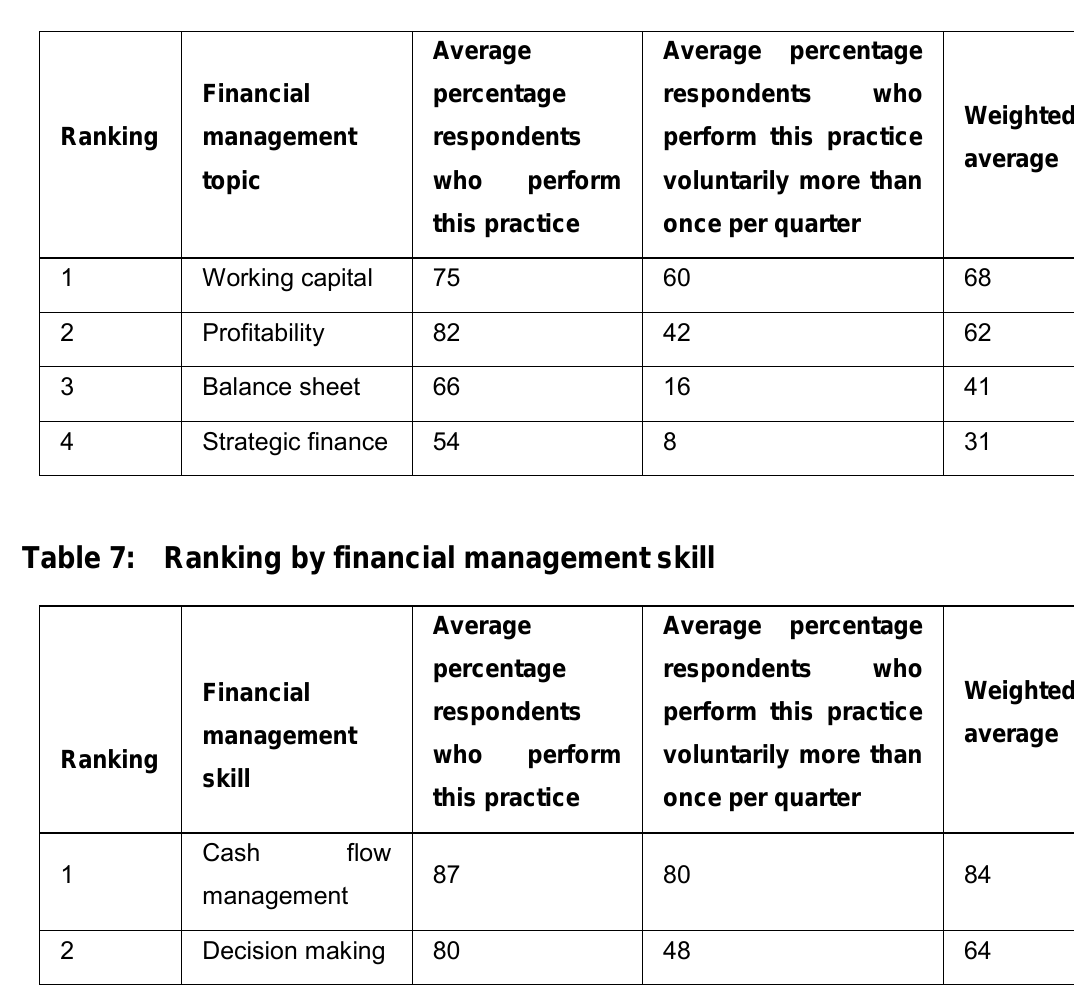
Ranking by financial management topic